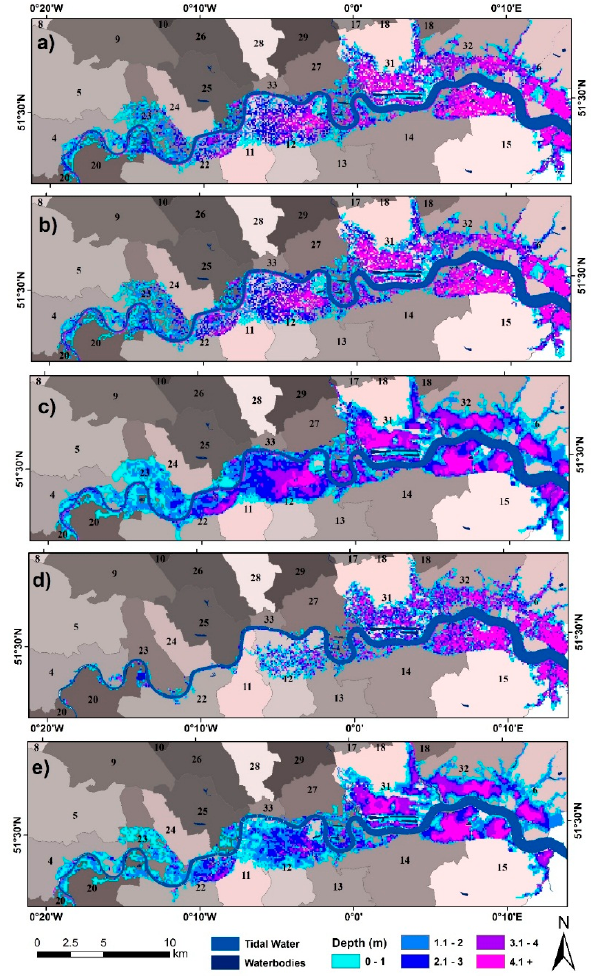
Figure 7. Flood depths obtained for inundated London boroughs from the eight-way hydrological connectivity approach by UKCP09 high++ sea-level rise scenario of 1.90 m. ( a ) 1 m LiDAR DEM; ( b ) 5 m LiDAR DEM Re ; ( c ) 5 m DEM; ( d ) 30 m SRTM DEM; and ( e ) 50 m DEM. Figure 1 gives the borough names that correspond to the numbers.